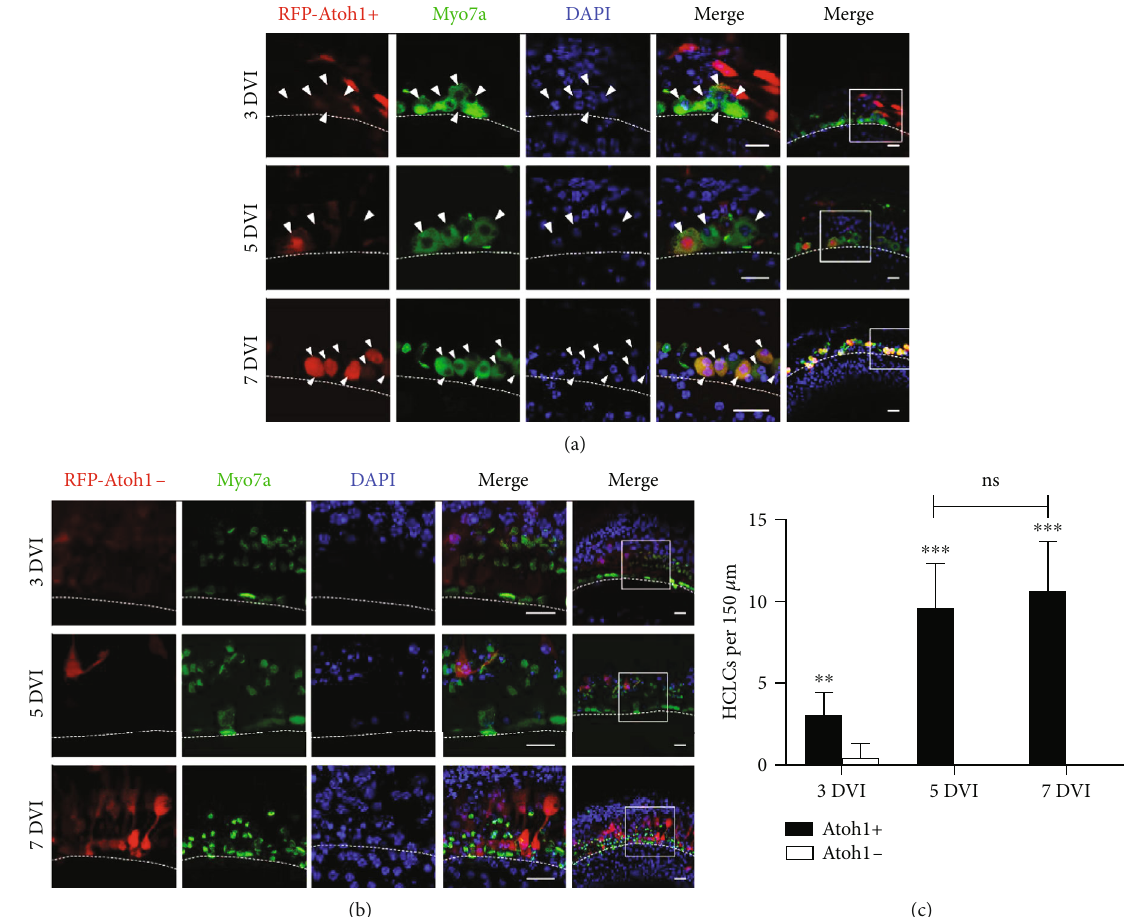
Figure 2: HCLCs were successfully induced from 3 DVI in vitro , and their numbers increased with time. (a, b) HCLCs (arrowheads) at 3, 5, and 7 DVI. RFP-Atoh1- was used as controls. (c) Quanti fi cation of HCLCs per 150 μ m cochlea length at 3, 5, and 7 DVI in both Atoh1+ and Atoh1- groups ( n = 5 ). Scale bars: 15 μ m in (a) and (b). Rectangular boxes show areas from which high magni fi cation and dashed lines mark the IHC